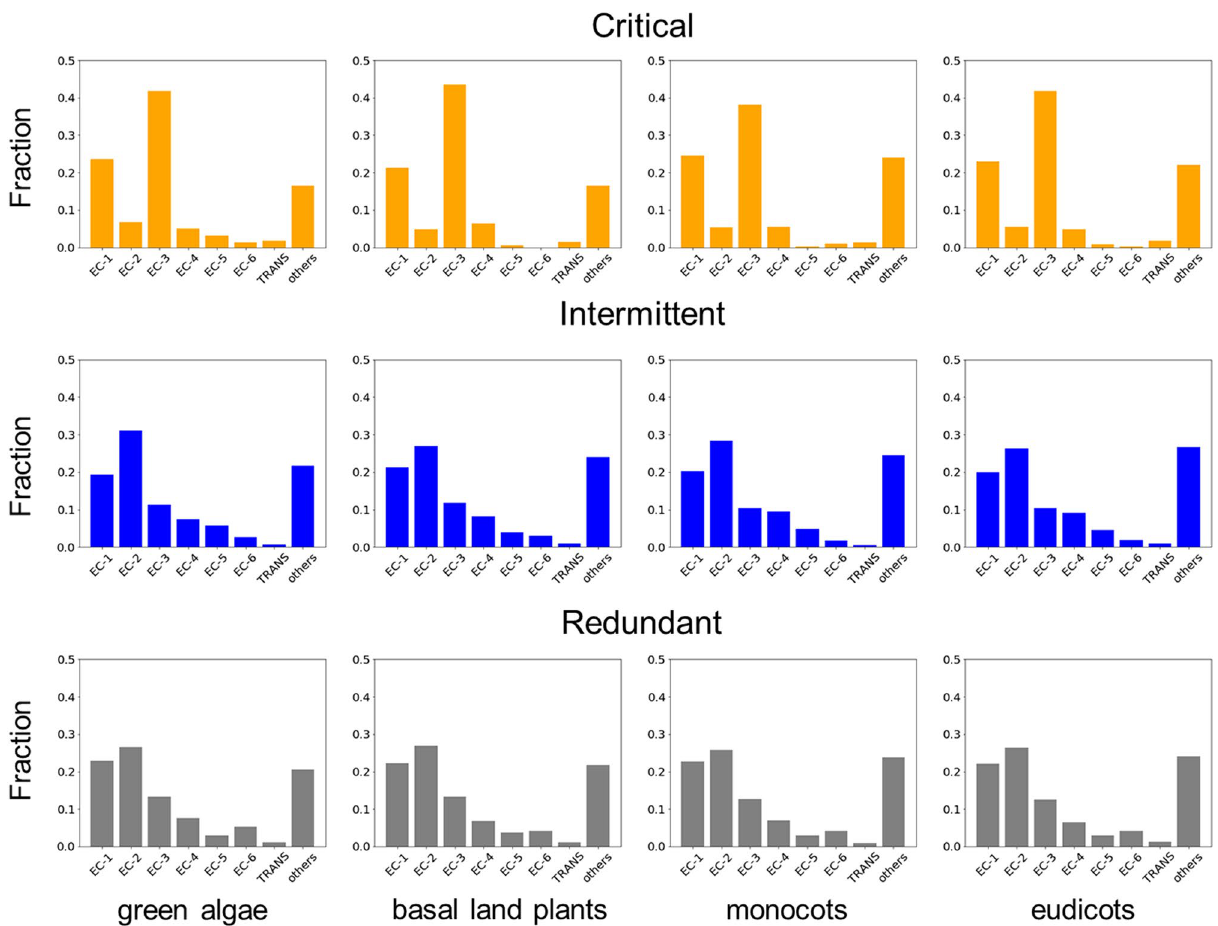
Figure 5. The distribution of critical, intermittent and enzymes according to each EC class and normalized for each plant lineage. Each fraction captures which EC class is more abundant for each plant lineage and control